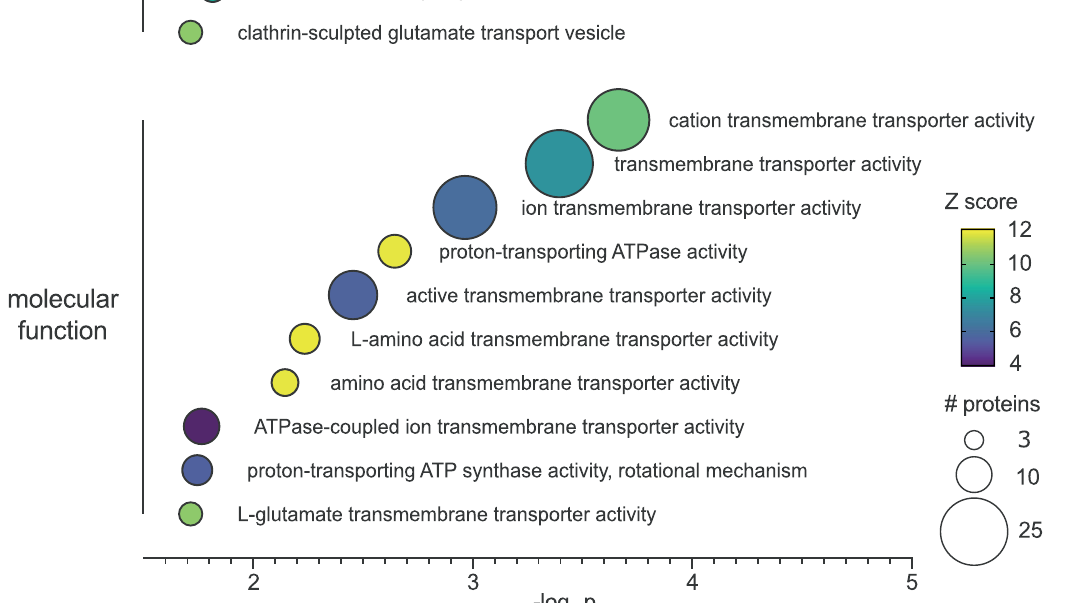
Fig. 5 Gene ontology analysis of synucleinopathy-associated insoluble proteomes indicates a plausible neuronal origin of GCIs. The list of 199 proteins gated previously (206 proteins enriched in both synucleinopathies — 7 speci fi c to PD or MSA, Fig. 4 black, DataSet 3 − 6, 7) was compared to the total list of 1022 proteins found in all Sarkospin pellets (DataSet 1) using Panther GeneOntology to calculate the statistical overrepresentation of biological processes (top), cellular components (middle) and molecular functions (bottom) gene ontology clusters in the synucleinopathy protein list. The bubble chart is representing the statistical signi fi cance ( − log 10 p , multiple comparisons corrected binomial test) of gene ontology clusters, with their color-coded Z score (FC × ( − log 10 p )) and size-coded number of represented proteins. Only signi fi cantly enriched (FC > 1.5; p < 0.05; # proteins > 3) clusters are represented on the graph (DataSet 8).